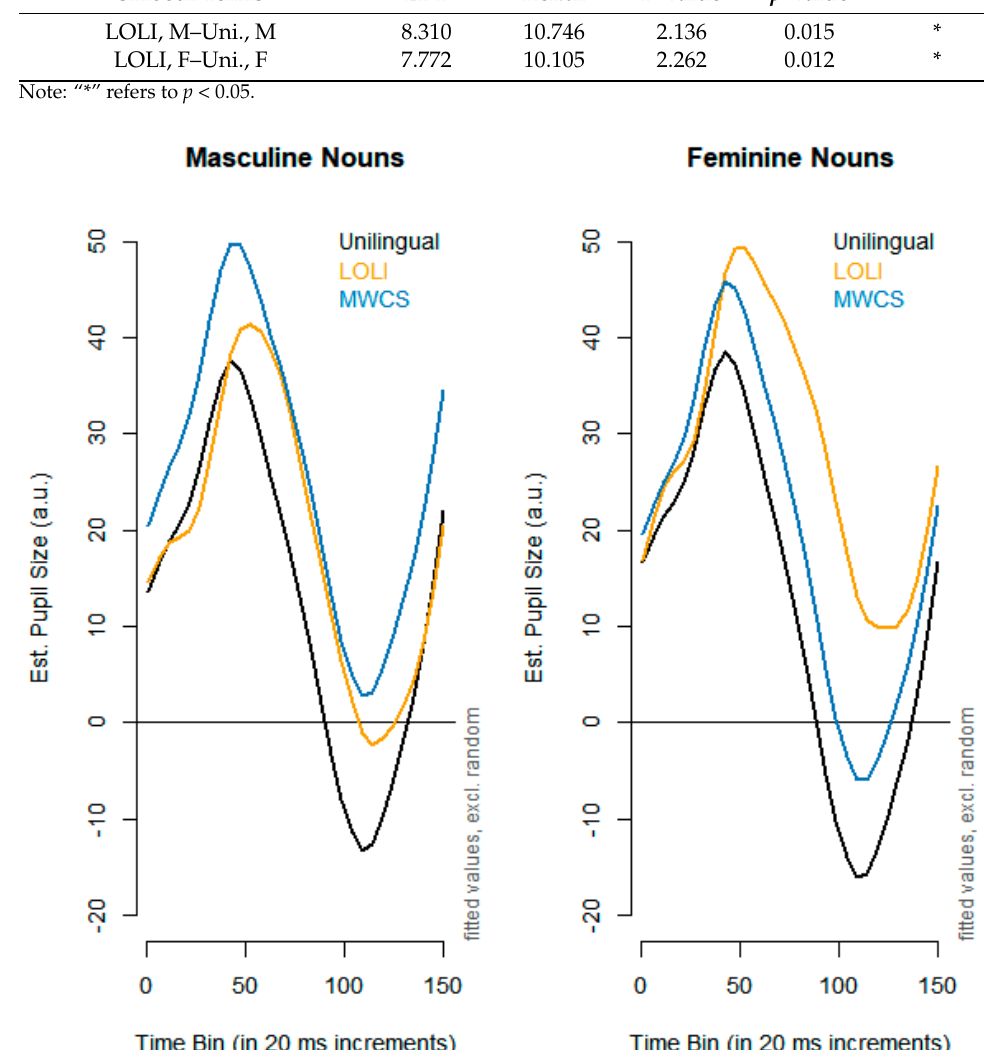
Figure 2. Fitted Figure 2. Fitted smooths.